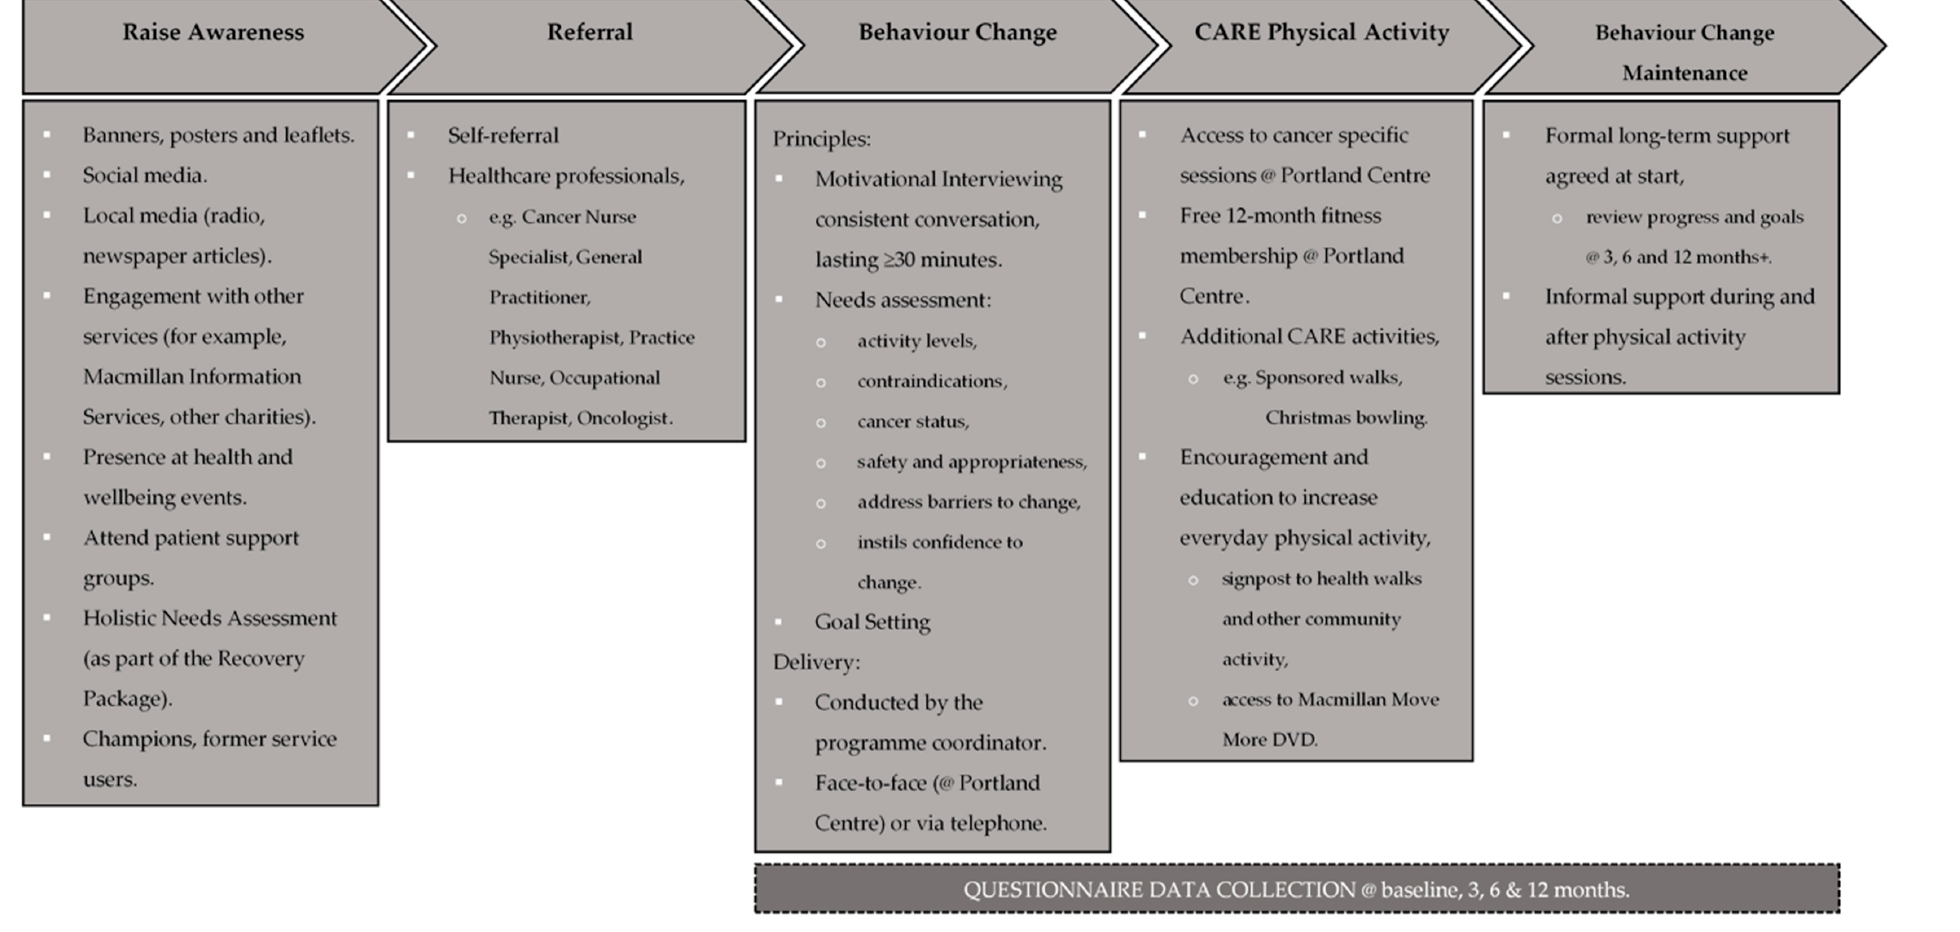
Figure 1. Overview of the key components of the Macmillan Physical Activity Behaviour Change Care Pathway applied to CARE.